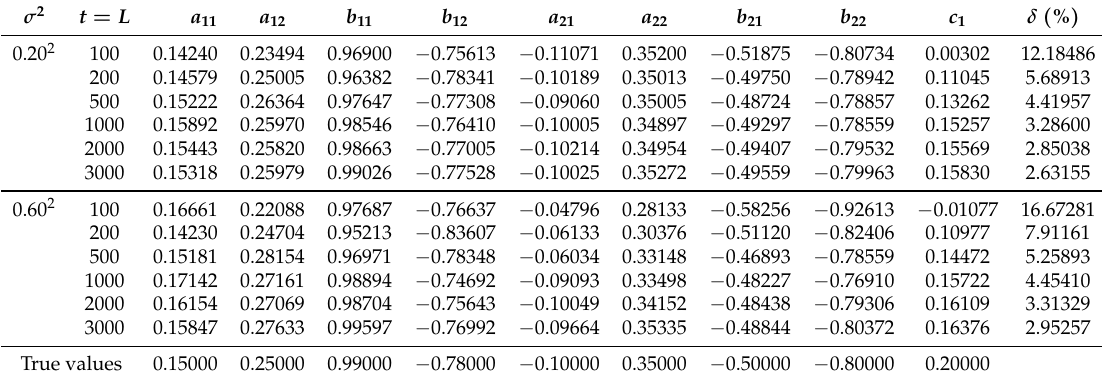
Table 1. The F-RGLS estimates and their errors for Example 1.